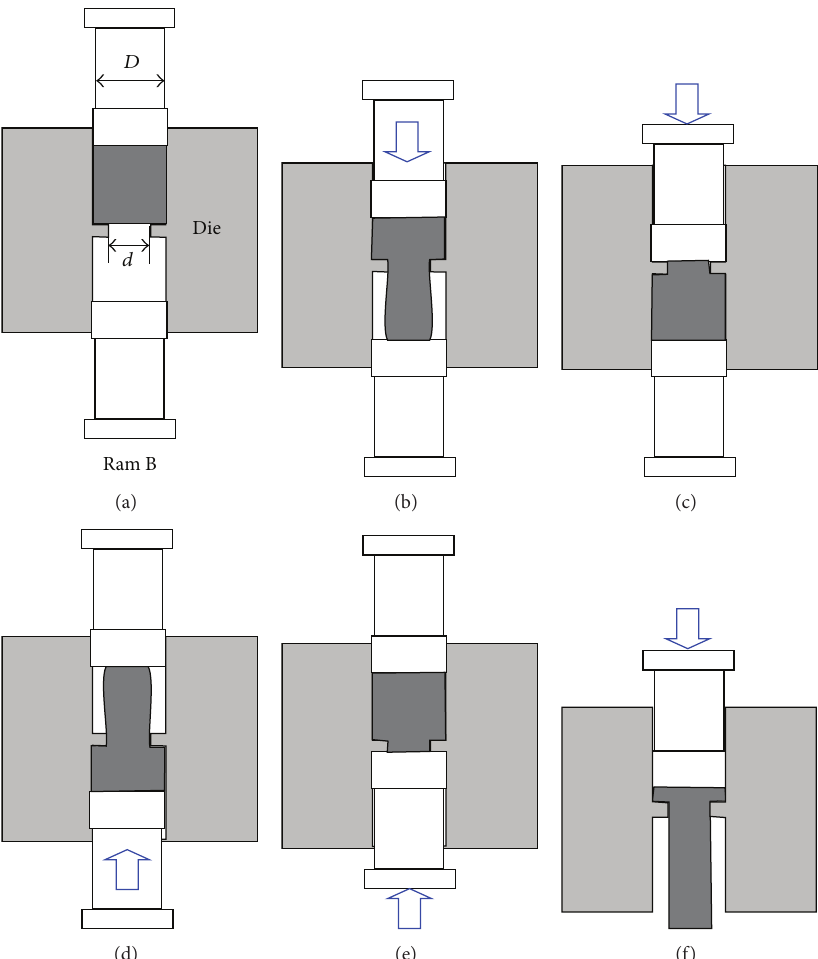
Figure 2: Schematic illustration of the CEC facility and procedures: (a) initial state, (b) extruding by Ram A, (c) end of Ram A involvement, (d) reverse extruding employing Ram B, (e) end of Ram B involvement, and (f) final extrusion to obtain a rod